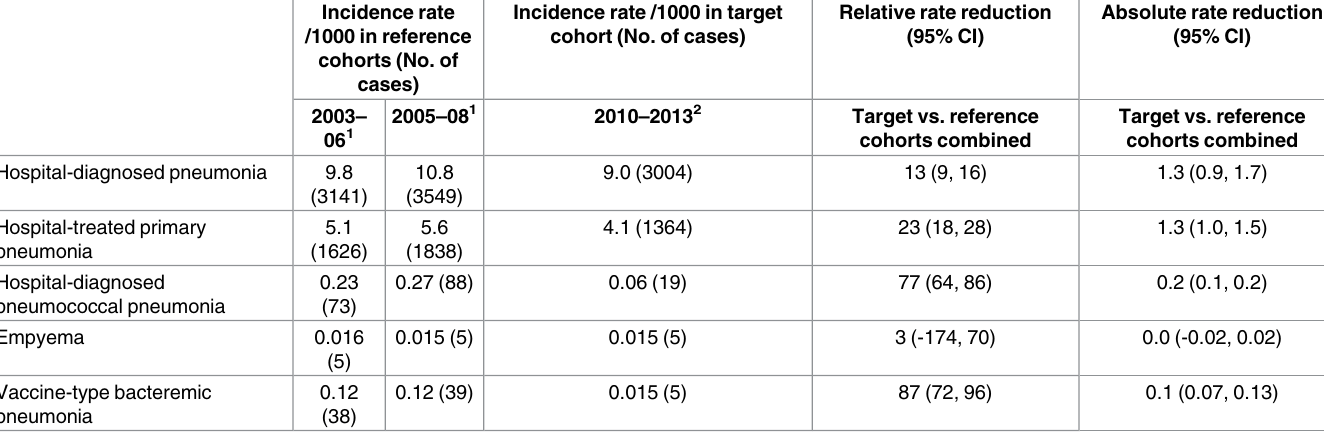
Table 2. Rates of pneumonia and the corresponding rate reductions in PCV10 eligible target cohort vs. referencecohorts. Incidence rate /1000 in